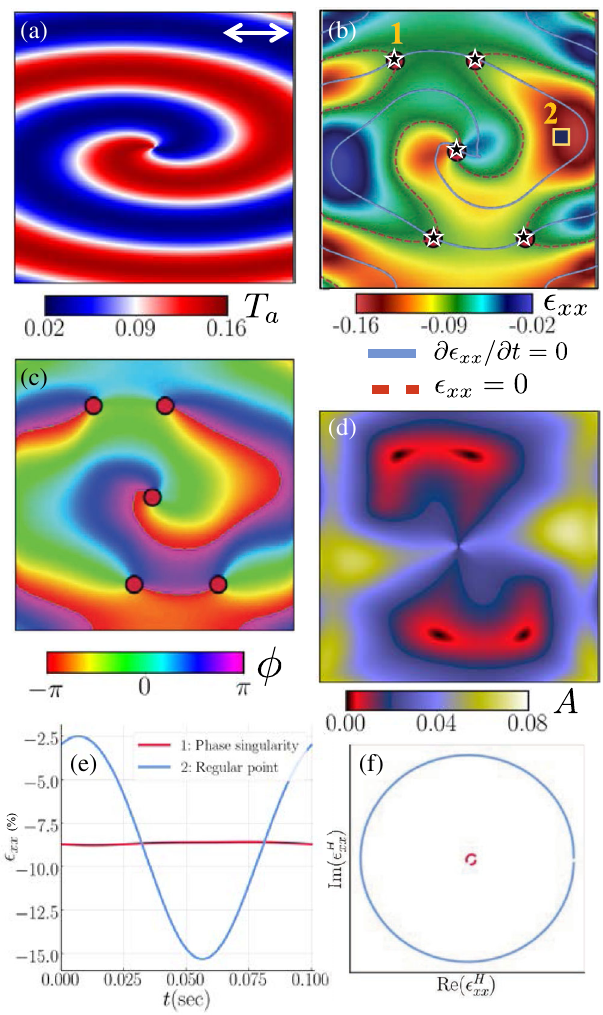
FIG. 4. Strain spiral wave pattern in an anisotropic 2D medium with fibers aligned along the x axis. (a) Clockwise rotating spiral x; y Þ . (b) Strain along the wave pattern of active contraction T a ð fibers ϵ vanishes in the horizontally aligned arms. Red circles and xx black stars with a white edge indicate the location of mechanical phase singularities calculated via the Hilbert transform and as the ϵ intersection of the ϵ contour (thin red dashed lines) and xx ¼ c ∂ ϵ 0 contours (thin blue lines), respectively, where ϵ is the t xx ¼ c average of the minimum and maximum values of ϵ . (c) Phase xx x; y Þ(cid:2) shows one colocalized mechanical map of the strain ϕ ½ ϵ xx ð phase singularity at the center of the rotor pattern in (a) and two additional pairs in the top and bottom horizontally aligned spiral arms. (d) The amplitude A of the complex transformed signal vanishes in the vicinity to all mechanical singularities (black regions). (e) Time series of ϵ for points 1 and 2 in (b). (f) Phase xx diagram at points 1 and 2 from (e) derived via the Hilbert transform, where the horizontal axis is the original signal and the vertical axis is the signal shifted by π = 2